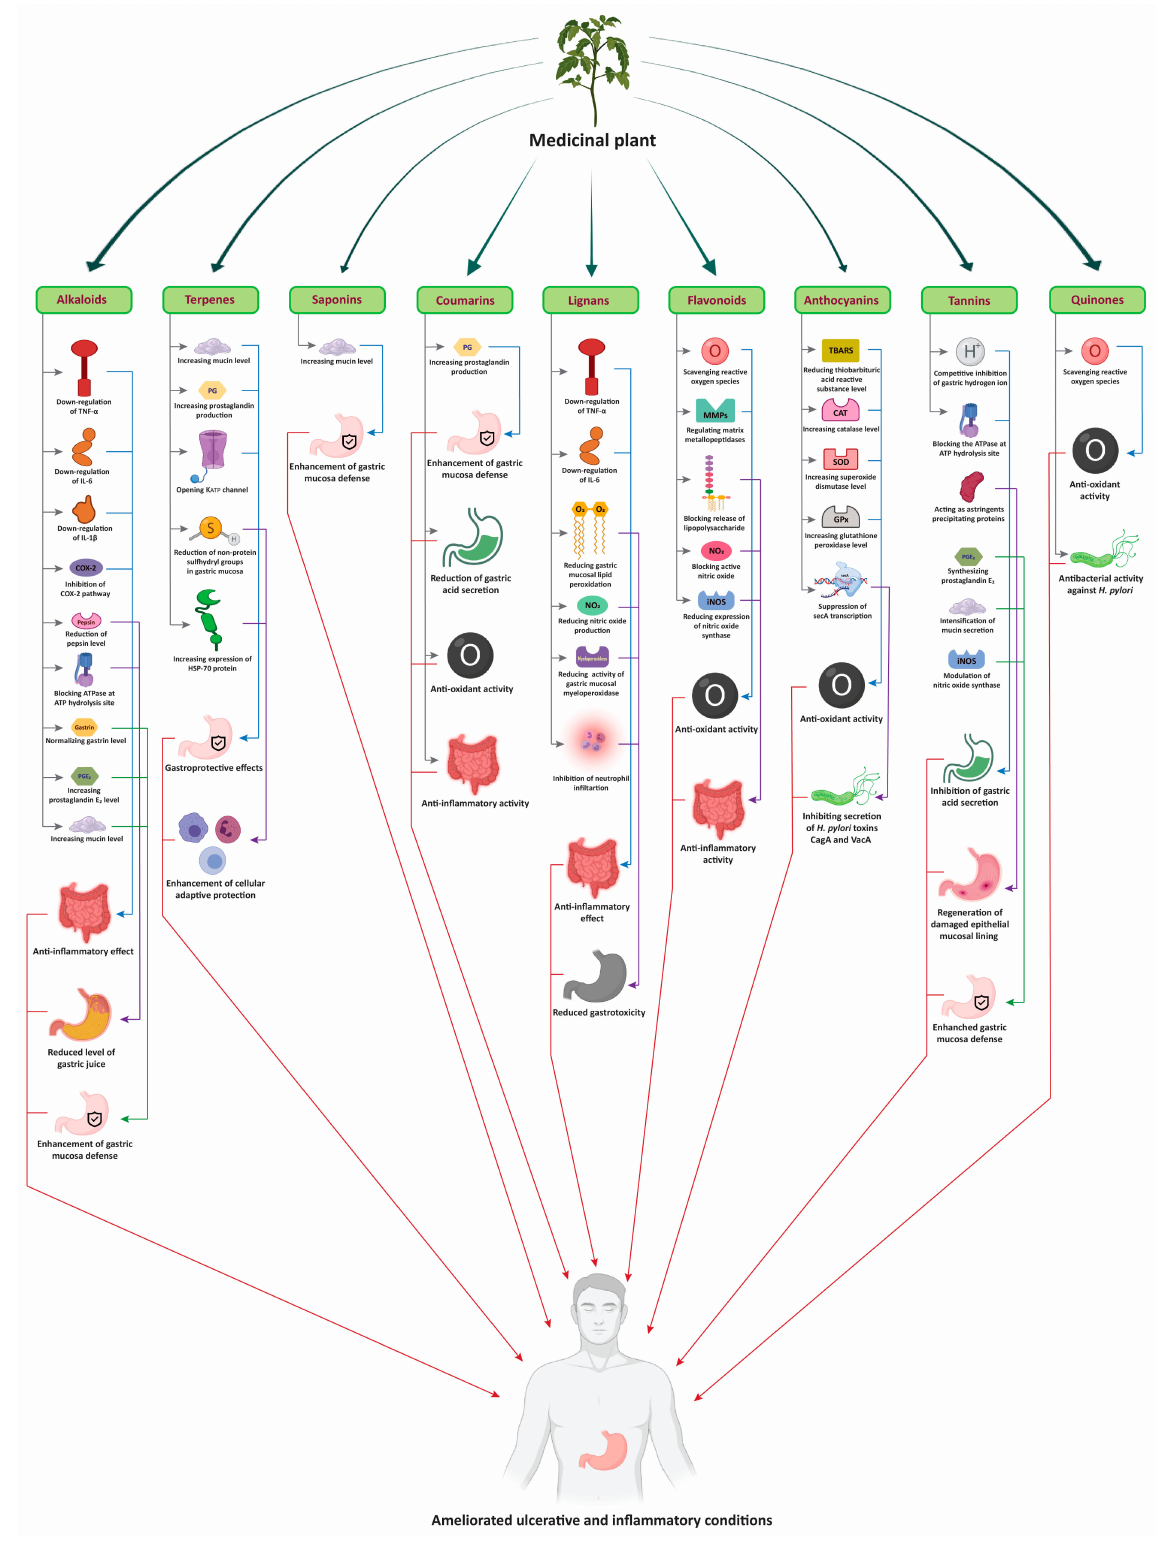
Figure 2. Modes of action of bioactive compounds of medicinal plants to treat ulcers and inflammatory